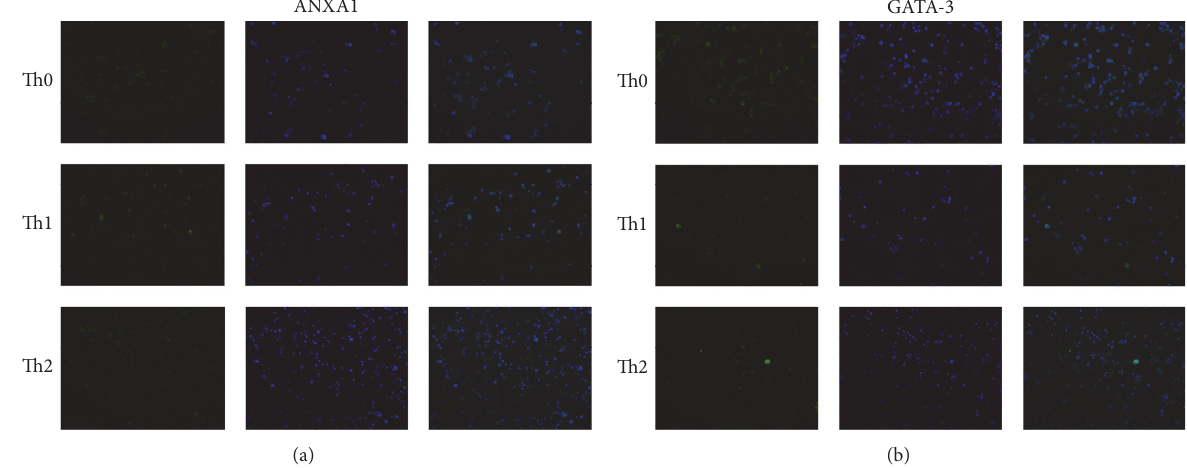
Figure 1: ANXA1 and GATA-3 expression on Th0, Th1, and Th2 and localization on cytoplasm and membrane. (a) Immunofluorescence analysis of ANXA1 expression on Th0, Th1, and Th2. Immunofluorescence was carried out using green fluorescent tagged secondary anti-ANXA1. The cell nuclei were stained with DAPI. (b) Immunofluorescence analysis of GATA-3 expression on Th0, Th1, and Th2. Immunofluorescence was carried out using green fluorescent tagged secondary anti-GATA-3. The cell nuclei were stained with DAPI.